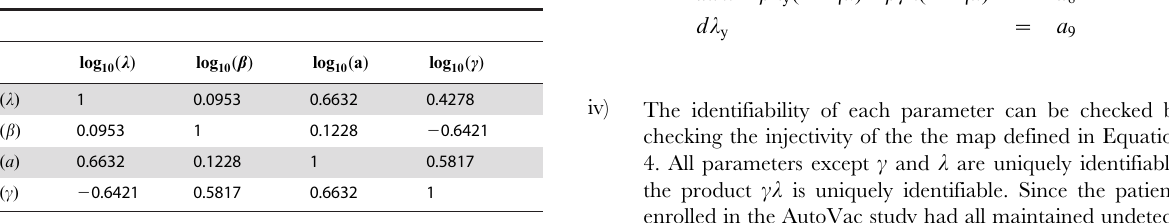
Table 1. The average correlation coefficients between parameters for all ten patients.